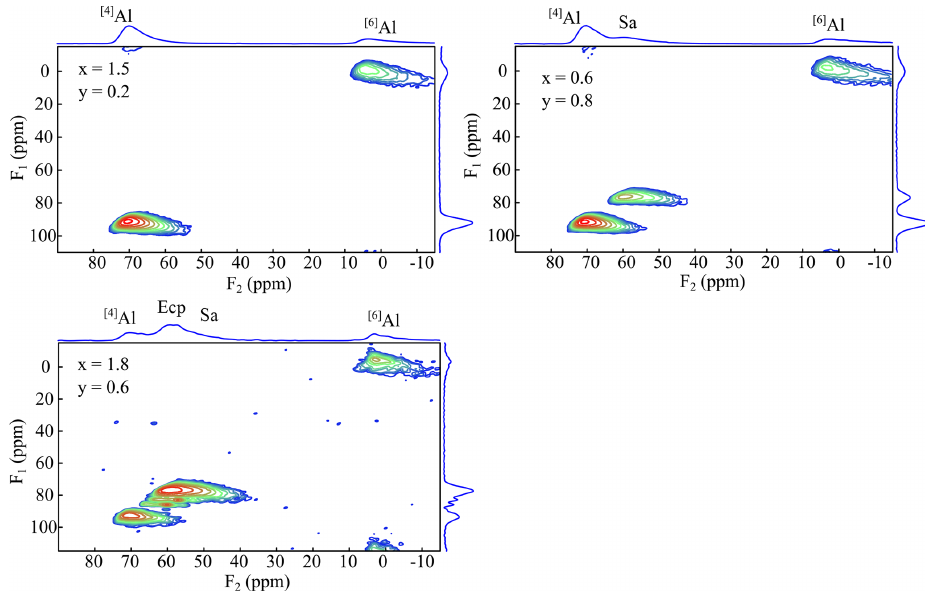
Figure 13. 27 Al MQMAS spectra of the samples x = 0 . 9, y = 1 . 4, and x = 1 . 7 and y = 1 . 0. The spectra show two signals belonging to the tetrahedral Al (73ppm) and the octahedral Al (6ppm). Ecp/Sa indicates the secondary phases eucryptite and sanidine,